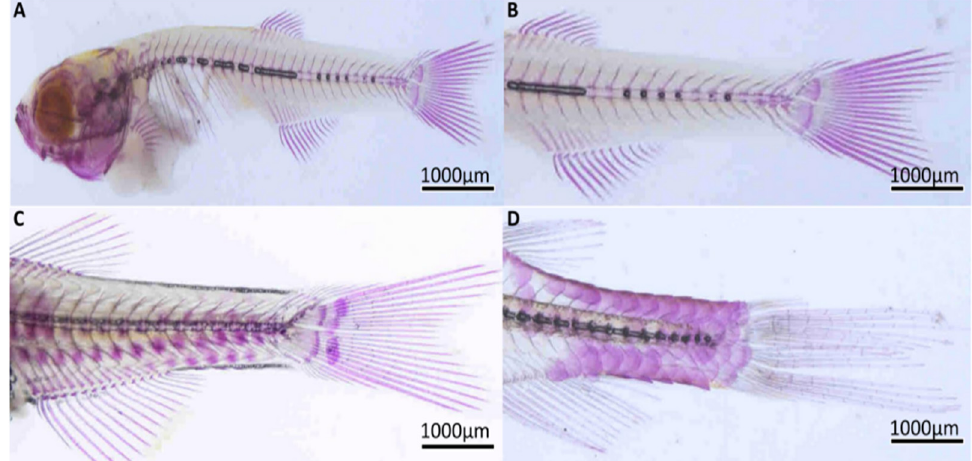
Figure 1. Alizarin red staining of tail scales at each sampling point for transcriptome analysis. ( A ) Whole-body staining of zebrafish stage I (~17 dpf). ( B ) Tail-scale staining of zebrafish at stage I (~17 dpf). ( C ) Tail-scale staining of zebrafish at stage II (~33 dpf). ( D ) Tail-scale staining of zebrafish at stage III (~41 dpf).